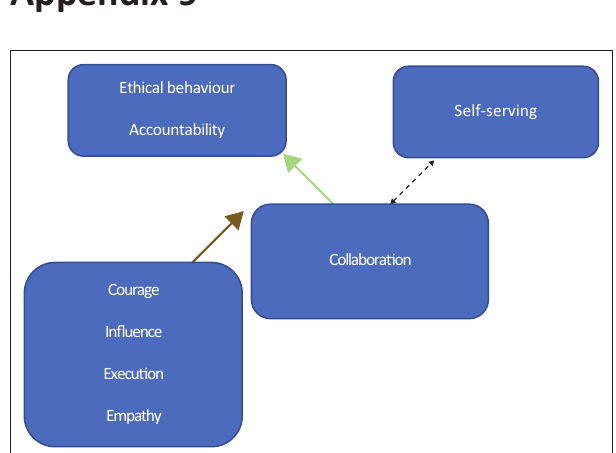
FIGURE 1-A9: Collaboration emerged as an important quality in social